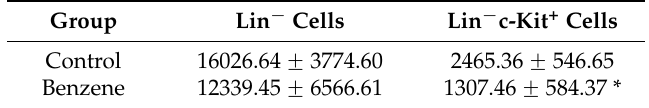
Table 3. Effect of benzene exposure on the numbers of HSPCs. Group